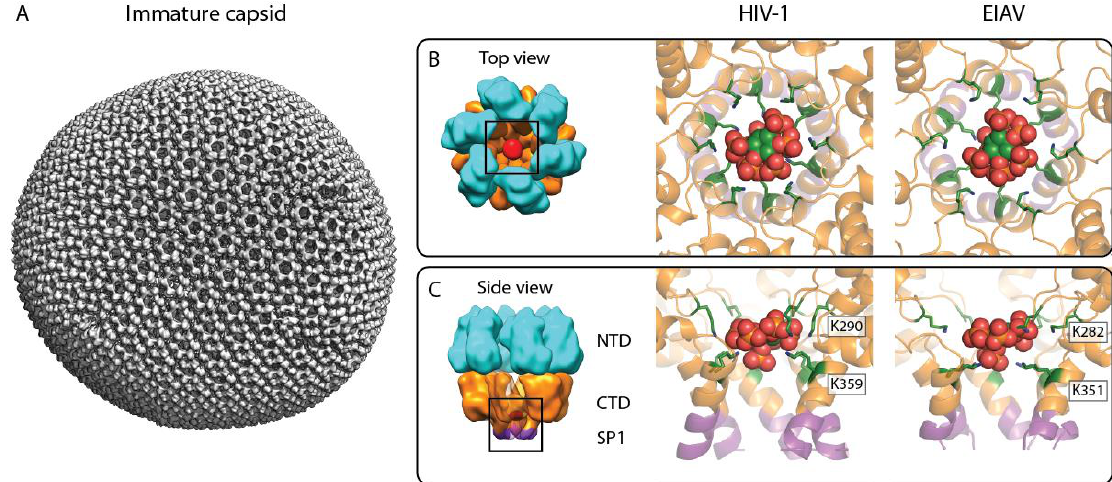
Figure 2. IP6 binding site in the immature retroviral CA lattice . ( A ) Composite isosurface representation of an immature retroviral CA lattice derived from an EIAV VLP, representative of the immature CA arrangement in the lentivirus genus. Please note that in authentic immature lentivirus particles, the Gag lattice is incomplete. ( B , C ) Top and side view of the IP6 binding site in the immature CA hexamer, respectively. Left: cartoon model of an immature CA hexamer; cyan: CA NTD , orange: CA CTD , purple: SP1, and red: IP6. Middle: X-ray crystallographic model of IP6 binding to the immature HIV-1 CA CTD – SP1 hexamer (pdb: 6BHR). Right: model of IP6 binding to the immature EIAV CANC hexamer, based on a structure solved by cryo-ET and subtomogram averaging (pdb: 6T64). The color coding for CA CTD – SP1 is as in the left panel. The IP6 molecule is shown as sphere representation in green, orange, and red. The lysines coordinating the IP6 molecule are shown in a green stick representation and are annotated.